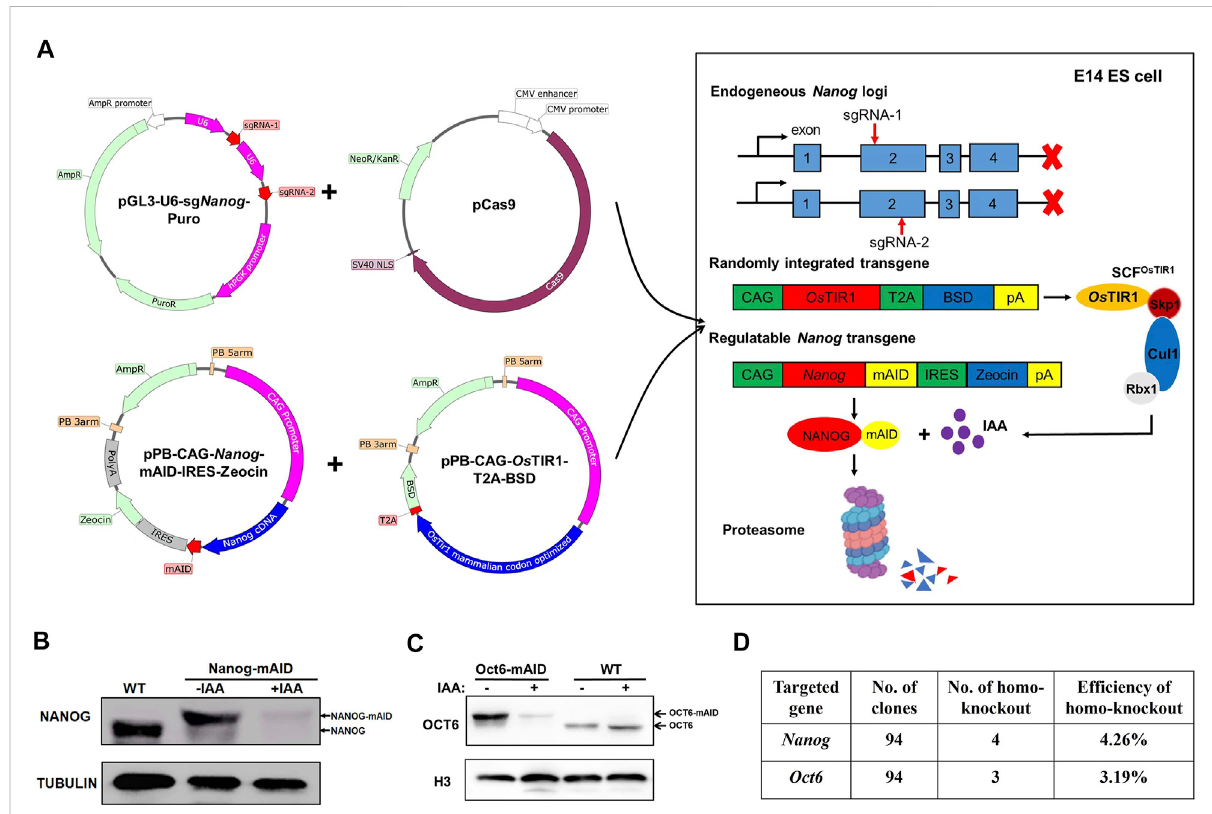
FIGURE 3 Generation of WT:Nanog-AID and WT:Oct6-AID cell lines in a one-step strategy. (A) Schematic diagram shown the generation of WT:Nanog- AID mESCs by aone-step strategy. (B) Immunoblot detection of NANOG-mAID and NANOG in WT:Nanog-AID ESCs. The addition of 500 μ M ofIAA for 24 h degraded NANOG-mAID fusion proteins. (C) Immunoblot detection of OCT6-mAID and OCT6 in WT: Oct6-AID ESCs. The addition of 500 μ M of IAA for 24 h degraded OCT6-mAID fusion proteins. (D) The ef fi ciency to generate WT:Nanog-AID and WT:Oct6-AID ESCs using a one-step